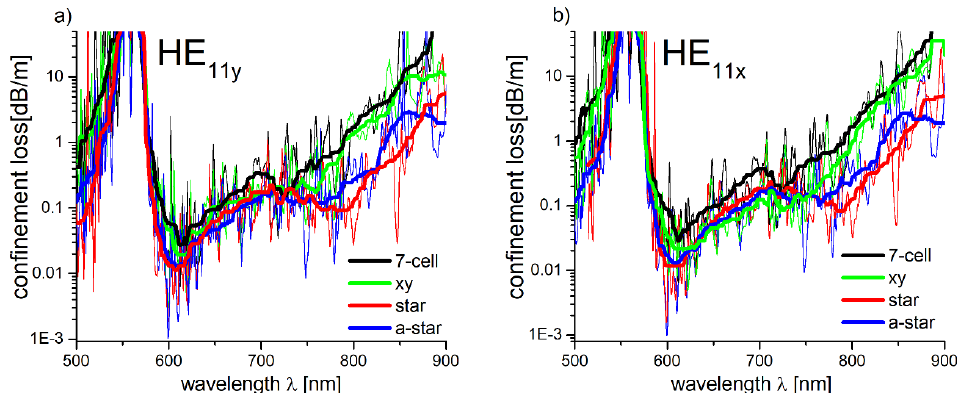
Figure 4. Calculated confinement loss spectra of the fundamental modes ( a ) HE 11x and ( b ) HE 11y for all simulated structures. In case of the modified structures, i.e., star and a-star, the loss values are (i.e., the x or y direction) has very little influence on the CL spectra of star and a-star